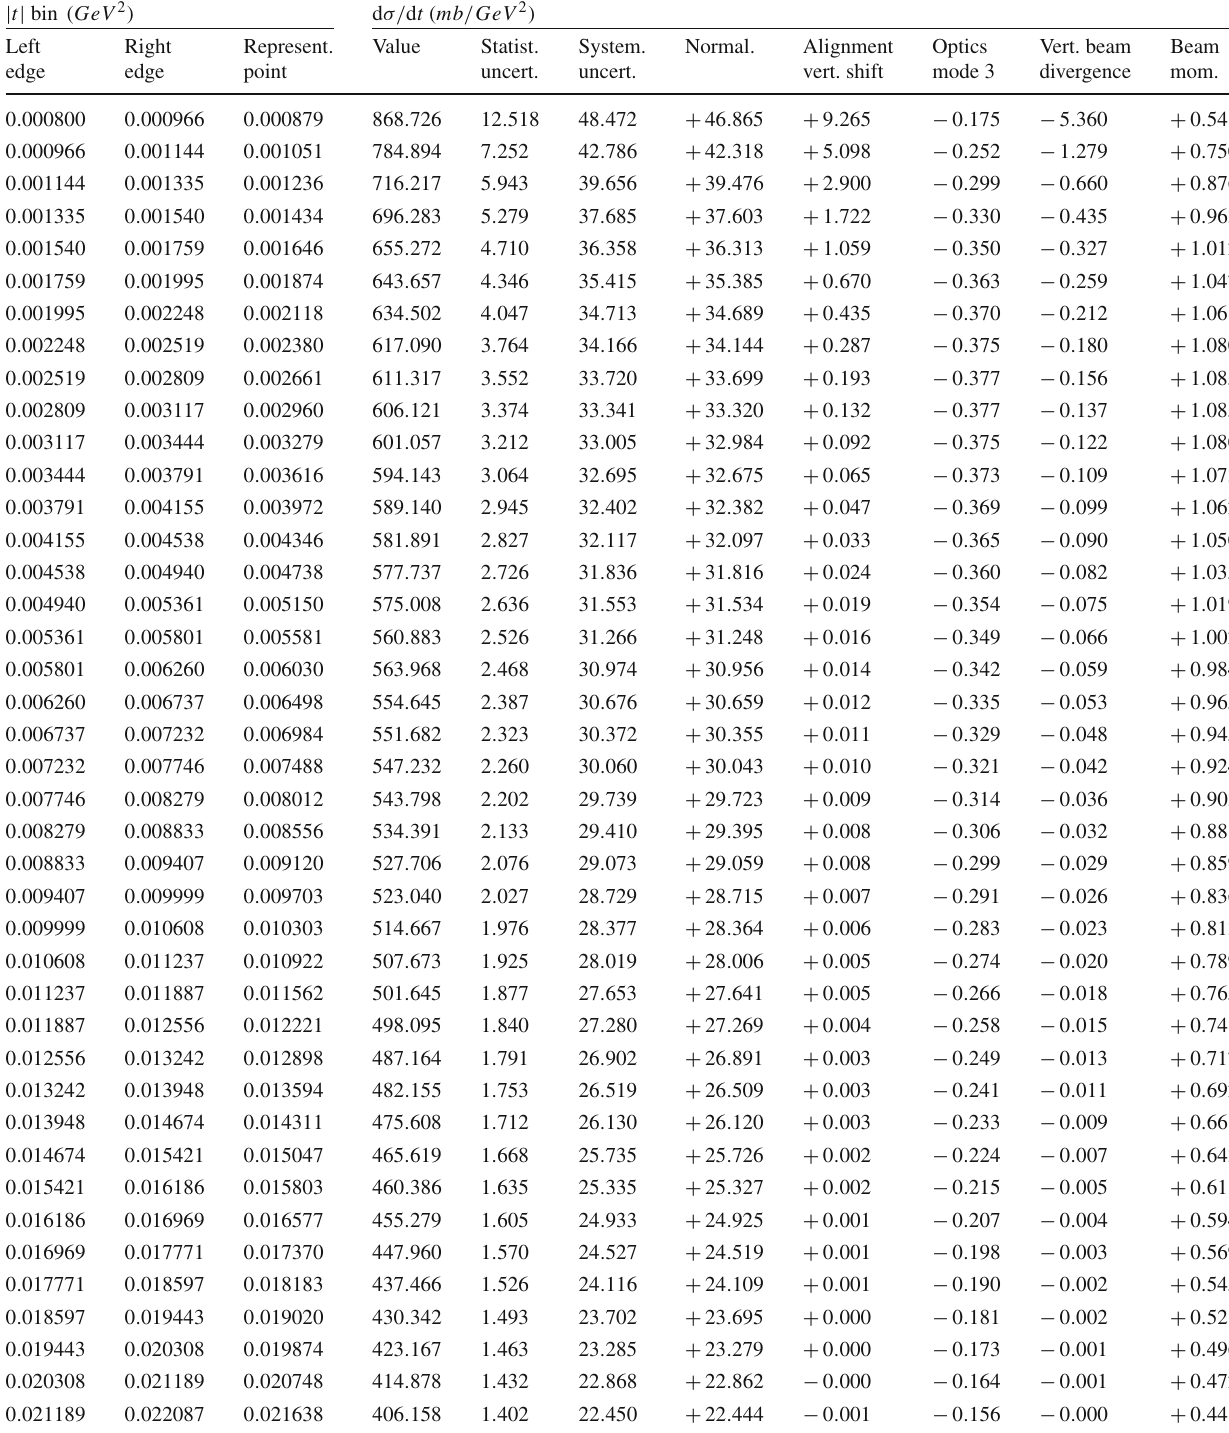
Table3 Theelasticdifferentialcross-sectionasdeterminedinthisanal- ysis (medium binning). The three leftmost columns describe the bins in t . The representative point gives the t value suitable for fitting [40]. The othercolumnsarerelatedtothedifferentialcross-section.Thefiveright- most columns give the leading systematic biases in d σ/ d t for 1 σ -shifts in the respective quantities, δ s q , see Eqs. (12) and (13). The contribu-